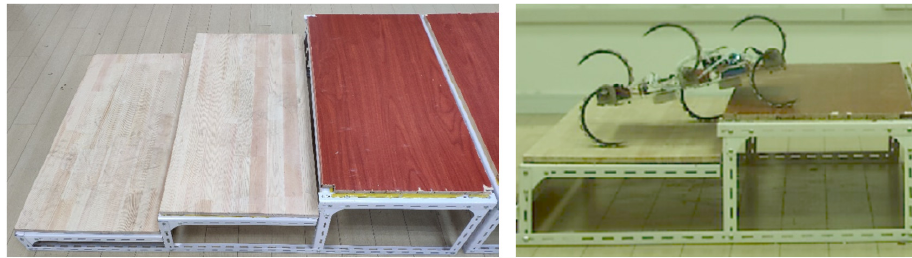
Figure 12. Experiment of robot crossing gullies. Table 3. Experimental results of robot obstacle-climbing task. Obstacle Height (cm)